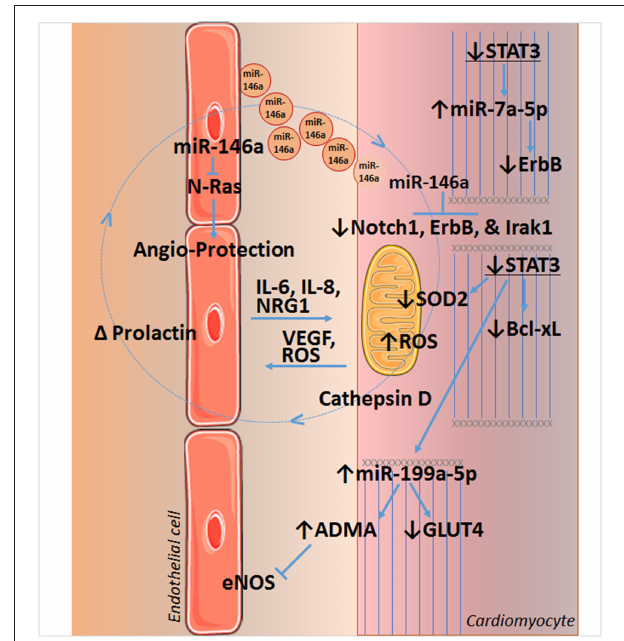
FIGURE 2 | STAT3 and crosstalk between endothelial cells and cardiomyocytes of the heart. Loss of STAT3 in cardiomyocytes leads to a decrease in SOD2 and Bcl-xL expression, resulting in increased reactive oxygen species (ROS) formation and apoptosis, respectively. Increased ROS is implicated in the upregulation of cathepsin D and formation of a shortened version of prolactin in peripartum cardiomyopathy, which induces miR-146a in endothelial cells. miR-146a has angiotoxic actions by targeting NRAS , which encodes for N-Ras that may act downstream of the VEGF or EGF receptors. Released in endosomes, endothelial miR-146a is taken up by cardiomyocytes and downregulates Notch1 (with beneficial or harmful effects that are context dependent), inflammatory Irak1, and the cytoprotective neuregulin receptor ErbB. Loss of cardiomyocyte STAT3 also upregulates miR-7a-5p that targets ErbB, as well as miR-199a-5p. Upregulation of miR-199a-5p decreases expression of the glucose transporter GLUT4 and leads to an increase in the endogenous inhibitor of eNOS and endothelial function, asymmetric dimethylarginine (ADMA), by impeding the ubiquitin-proteasome system (UPS). Impairment of UPS is associated with disruption of sarcomere structure as well. Cardiomyocyte STAT3 is also linked to VEGF expression. See text for additional details. Images of endothelial cells and mitochondrion are from Servier Medical Art